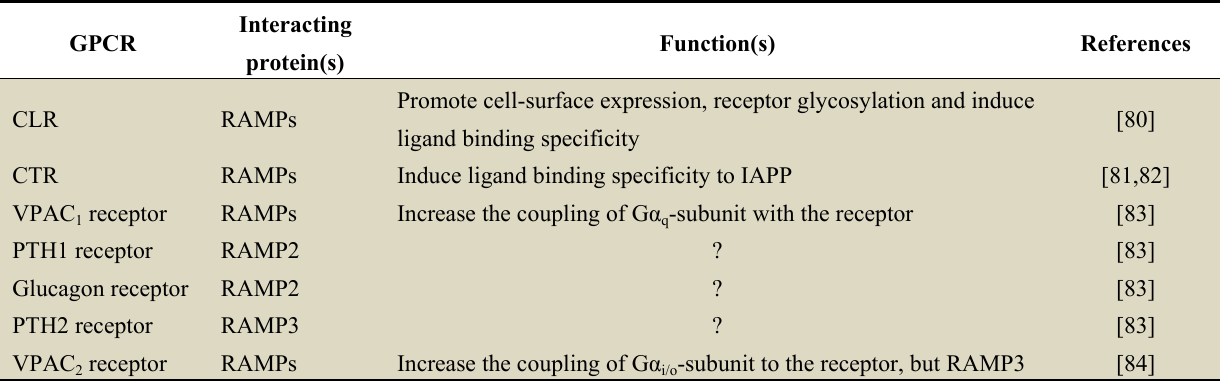
Table 2. Interacting proteins that influence both cell-surface localization and signaling of GPCRs.